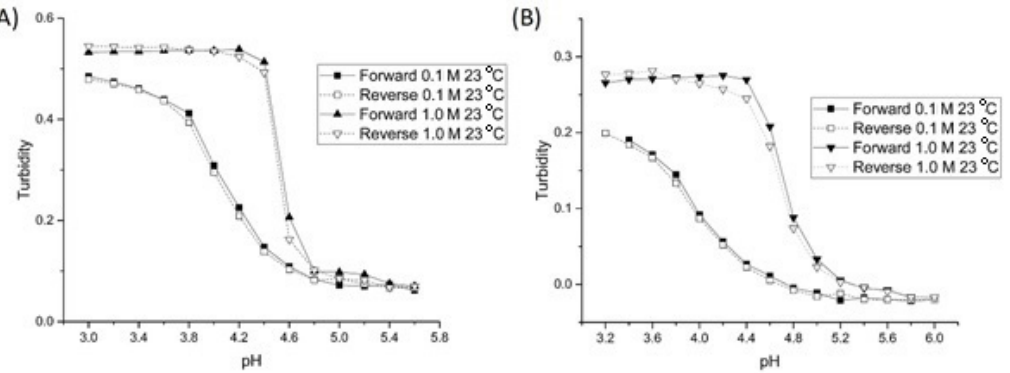
Figure 4. pH response curves of ( A ) NK 1-28 and ( B ) NK 1-77 at 0.1 and 1.0 M ionic strength.